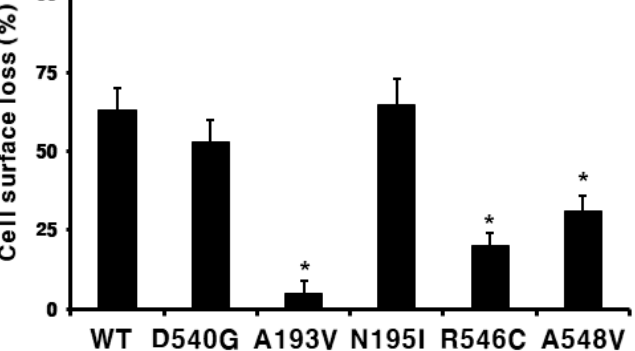
Figure 6. Cell surface loss of wild-type eelFSHR and activating / inactivating mutants. Each mutant plasmid was transiently transfected into the HEK-293 cells. The cells were incubated with or without 1000 ng/mL recombinant eelFSH (rec-eelFSH) for 30 min. Subsequently, the cell surface expression of the receptors was determined. The results are expressed as percentages of the cell surface loss of the receptor. Cell surface losses of the wild-type and mutant eelFSHRs were calculated by comparing levels in the presence of rec-eelFSH to levels in the absence of agonist treatment (taken as 0% cell surface loss). The results are expressed as the means ± SE of three independent experiments. * Statistically significant di ff erences in cell surface loss of receptor ( p < 0.05) compared to cell surface of the wild-type receptor.